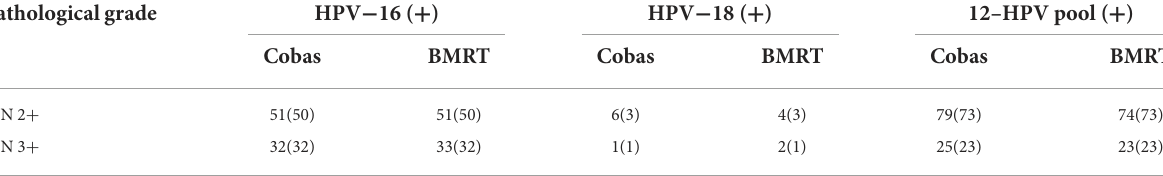
TABLE 2 The number of positive cases in CIN2 + /CIN3 +